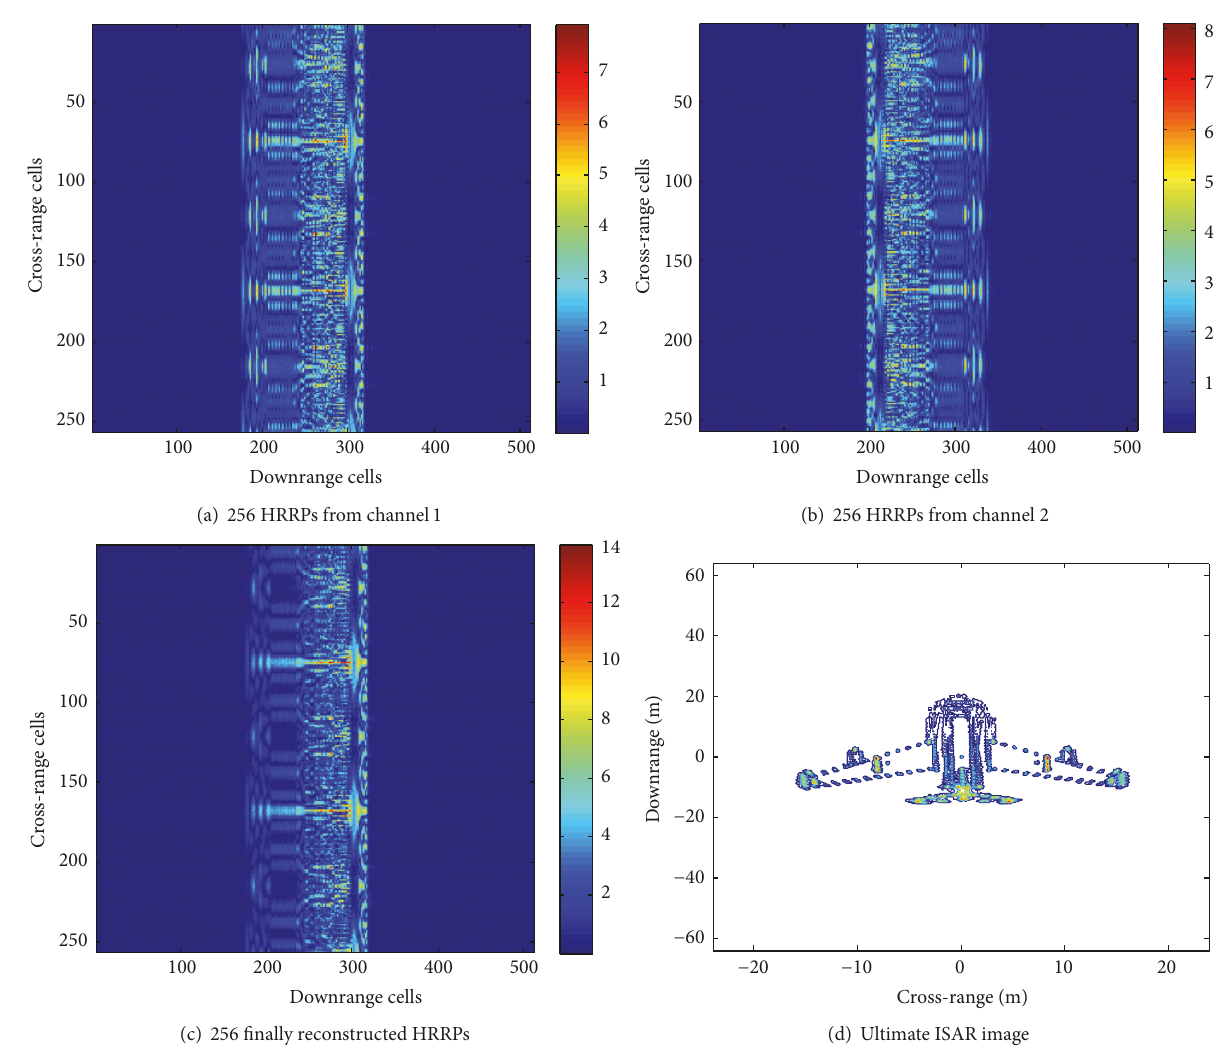
Figure 8: ISAR image formation of the Yak-42 plane model (SNR = 20